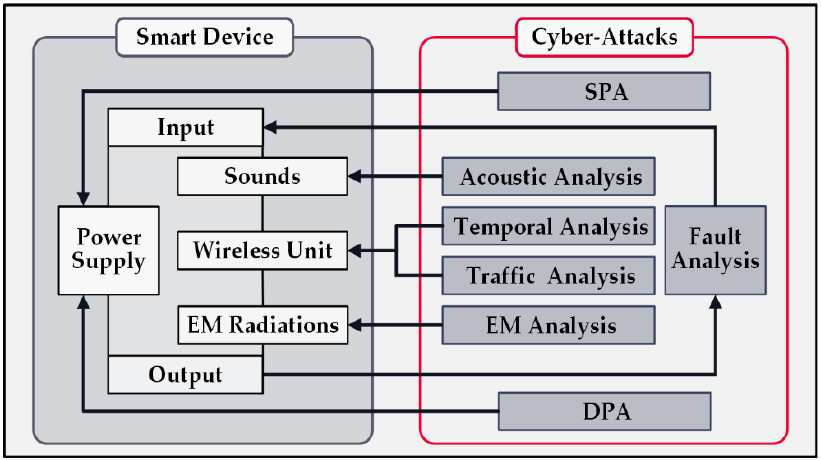
Figure 3. Side-channel attacks on a smart device.